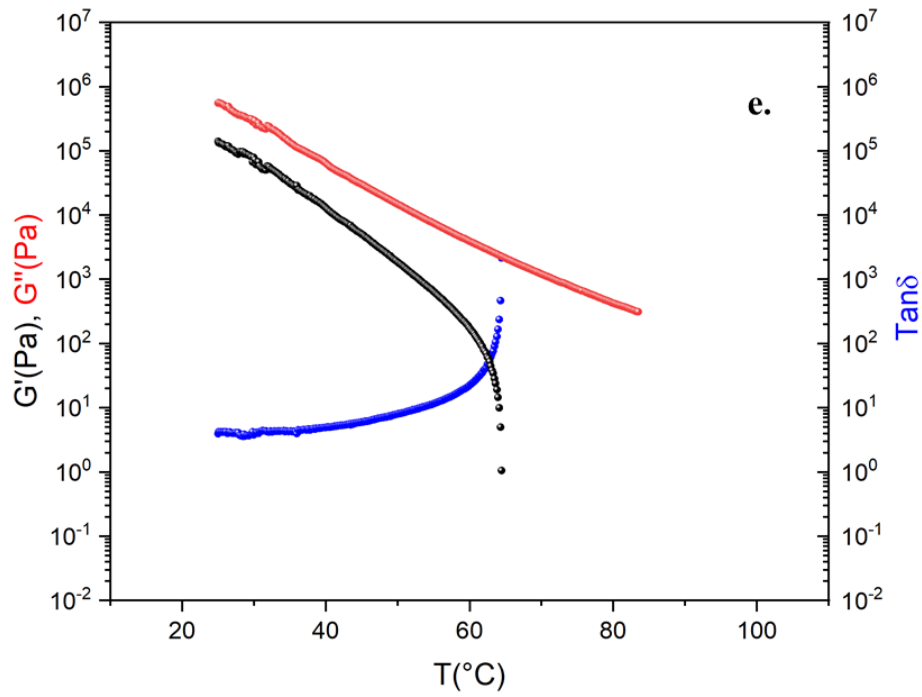
Figure 3. Dynamic Temperature Ramp Test of ( a ) V2F, ( b ) V2D, ( c ) V1, ( d ) V2TQ, ( e ) Pen 50/70.